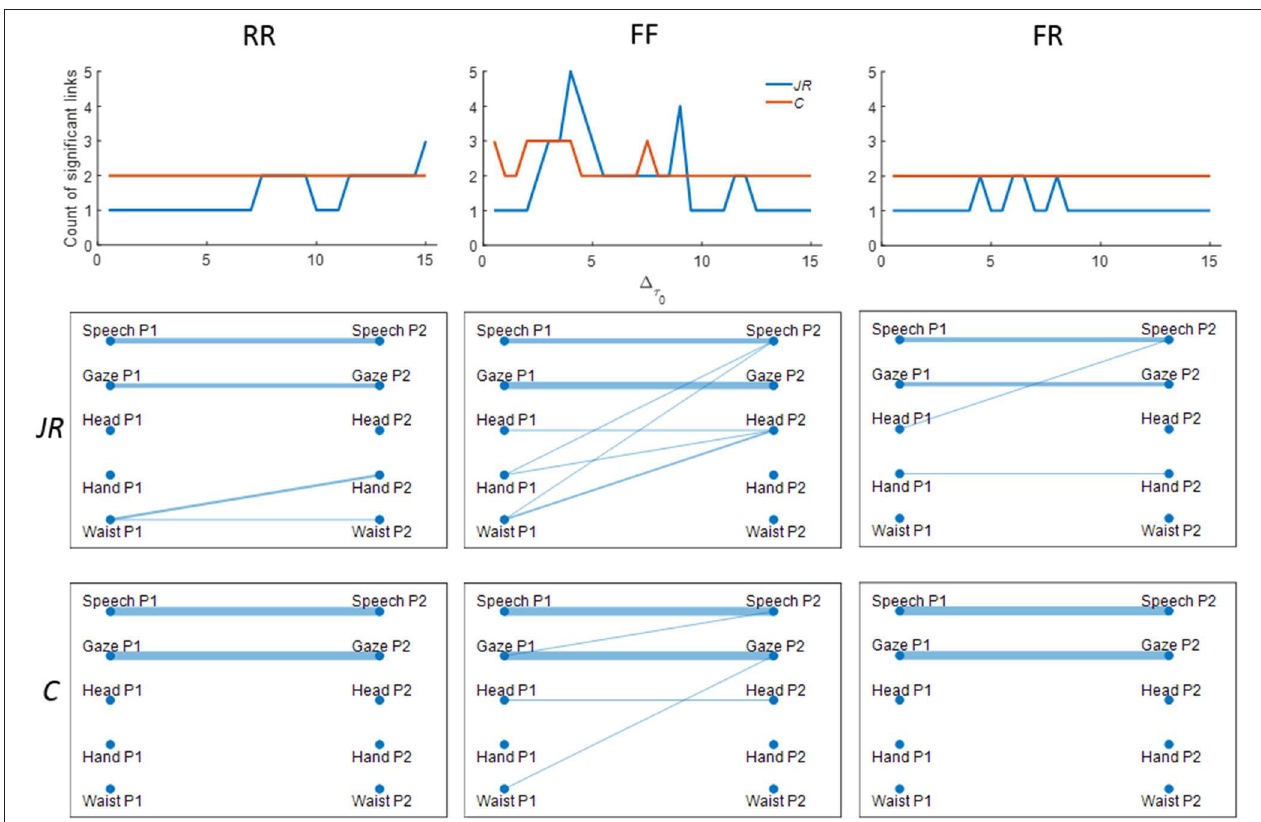
FIGURE 3 | Figures summarizing graph density and topology for interpersonal data calculated using %TDS. Columns correspond to the three levels of hand restraint placed on the interacting pairs. The first row shows the count of significant links as a function of the TDS similarity threshold ( 1 τ cross-correlation-based measures. The second and third row are networks showing the significant links between person one (P1) and person 2 (P2) identified by the JRQA-based and cross-correlation-based methods. The thickness of the lines in the graphs indicate the proportion of times that link was identified as significant over all values of 1 τ 0